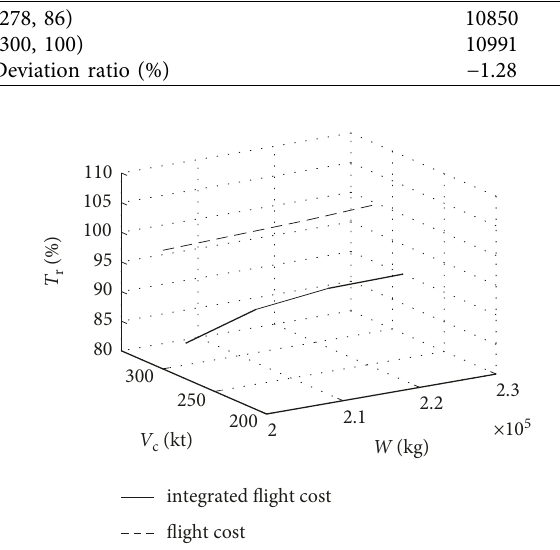
Figure 6: Effect of flight weight on optimization parameters.